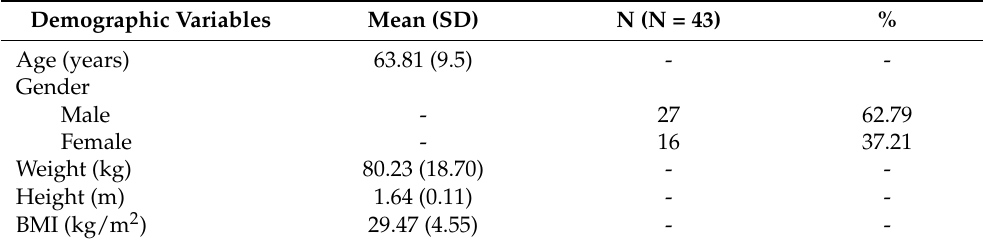
Table 2. Demographic variables of the sample that participated in the internal consistency and test-retest reliability